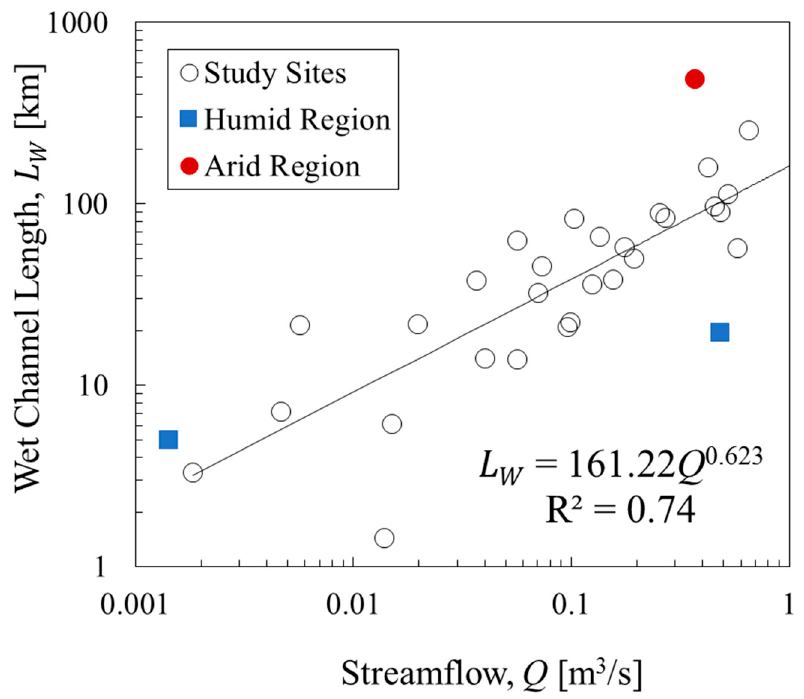
Figure 5. The relationship between streamflow ( Q ), presented in Table 1, and wet channel length ( L W ) in the study ( 𝐿 (cid:3024) ) in the study watersheds.